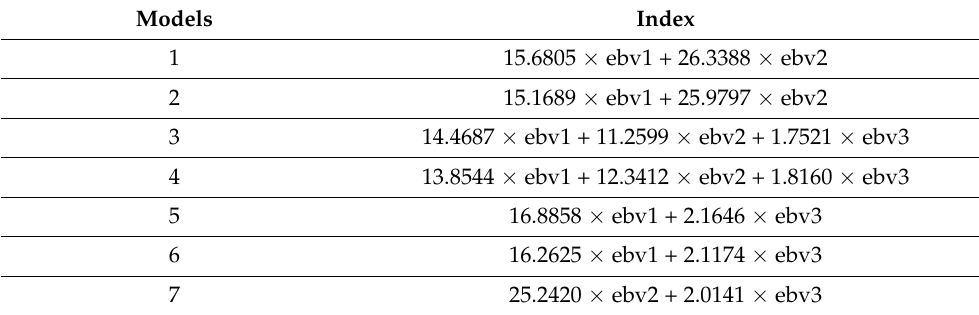
Table 9. Selection indexes weighting factors for the examined traits.